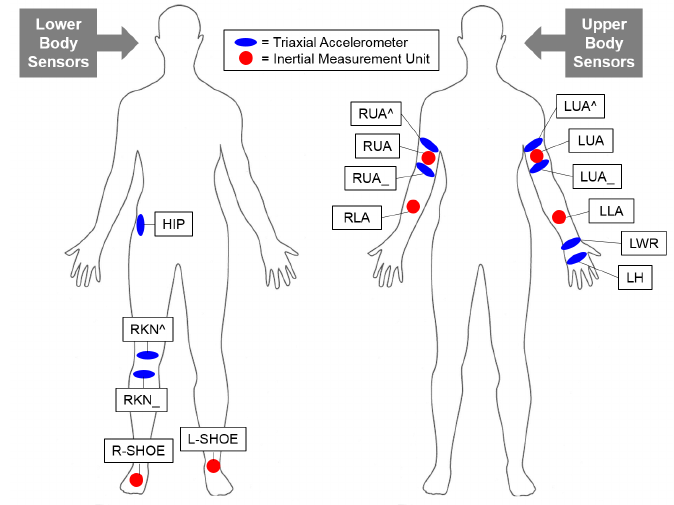
Figure 7. Lower (left) and upper (right) body sensors selected for OPPORTUNITY dataset experiment. For the lower body sensors, we chose three triaxial accelerometers (marked in blue) located at the right hip (HIP), right knee (RKN^), and right knee (RKN_), and three inertial measurement units (marked in red) located at the right (R-SHOE) and left shoe (L-SHOE) for the experiments. For the upper body sensors, we chose six triaxial accelerometers located at the right upper arm (RUA^), right upper arm (RUA_), left upper arm (LUA^), left upper arm (LUA_), left wrist (LWR), and left hand (LH), and four inertial measurement units located at the right upper arm (RUA), right lower arm (RLA), left upper arm (LUA), and left lower arm (LLA). Table 1. Activity class constitution and number of samples in OPPORTUNITY dataset; the same class label constitution applied to both the lower and upper body sensor data. Class Up